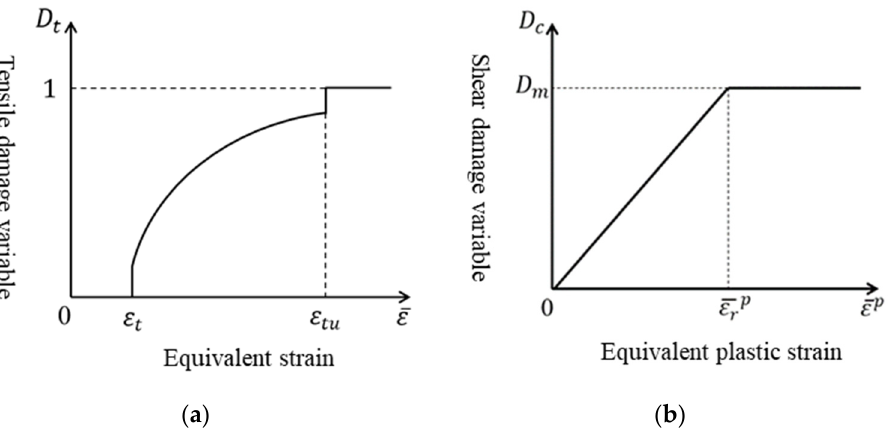
Figure 8. Schematic diagram of the evolution of unloading softening damage variables: ( a ) Tensile damage variable, ( b ) shear damage variable.